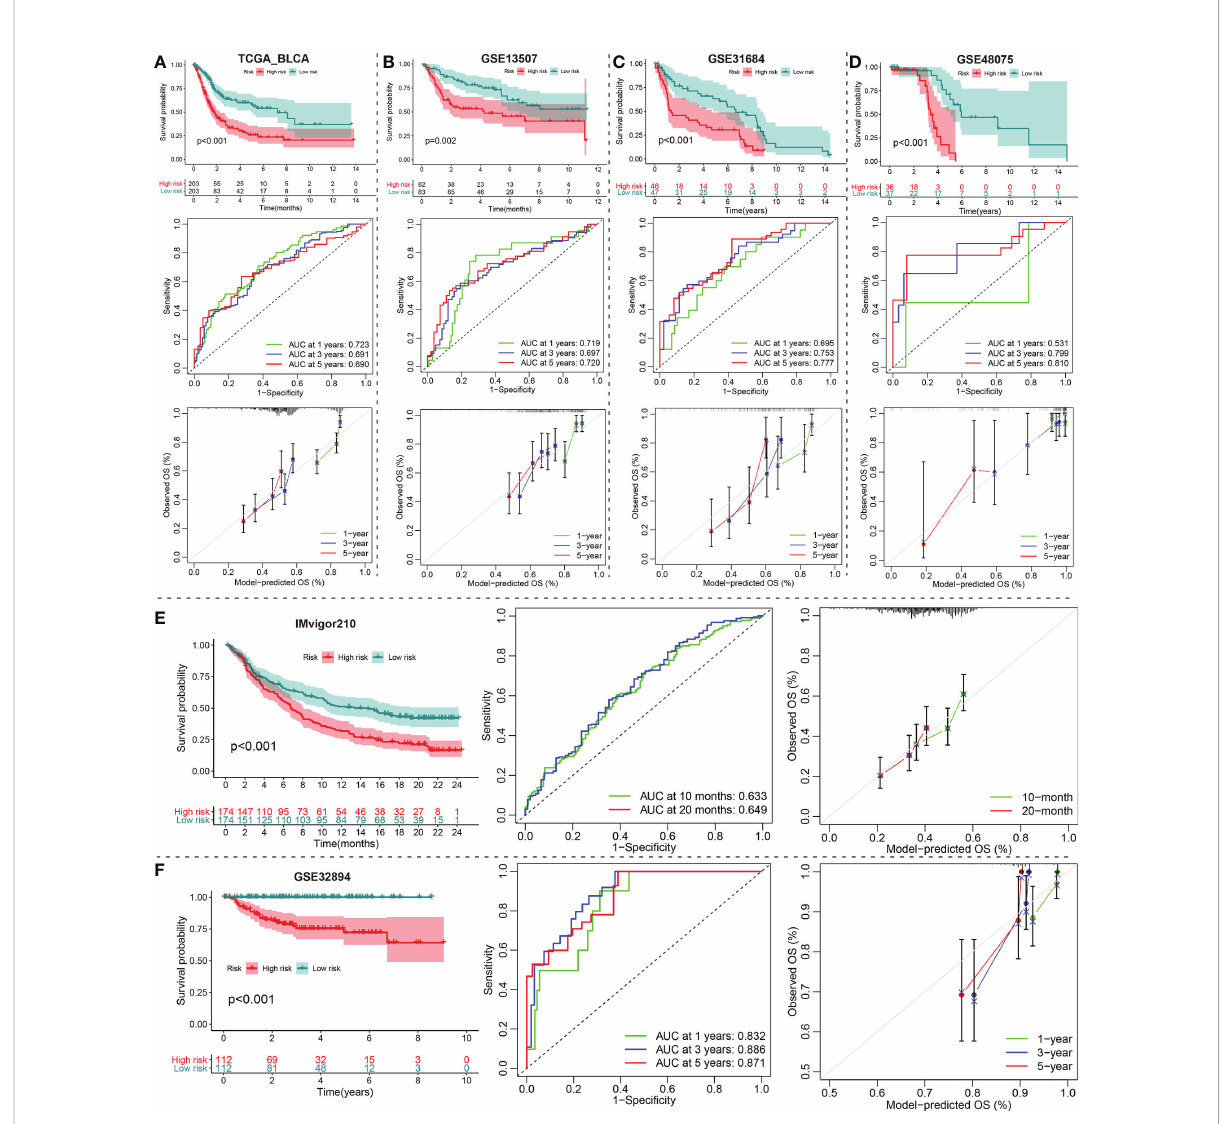
FIGURE 5 Construction and validation of a DE-mRNAs of the ceRNA network Signature. (A) The Kaplan-Meier, ROC and calibration curves of the 1-, 3-, and 5-year OS rate prediction for patients with BCa based on the risk score for the TCGA_BLCA training cohort. (B – F) Kaplan-Meier, ROC and calibration curves of the risk score for the 1-, 3-, and 5-year OS rate prediction for the testing set, including GSE13507, GSE31684, GSE48075, IMvigor210 and GSE32894. ceRNA, competing endogenous RNA; BCa, bladder cancer; DE-, differentially